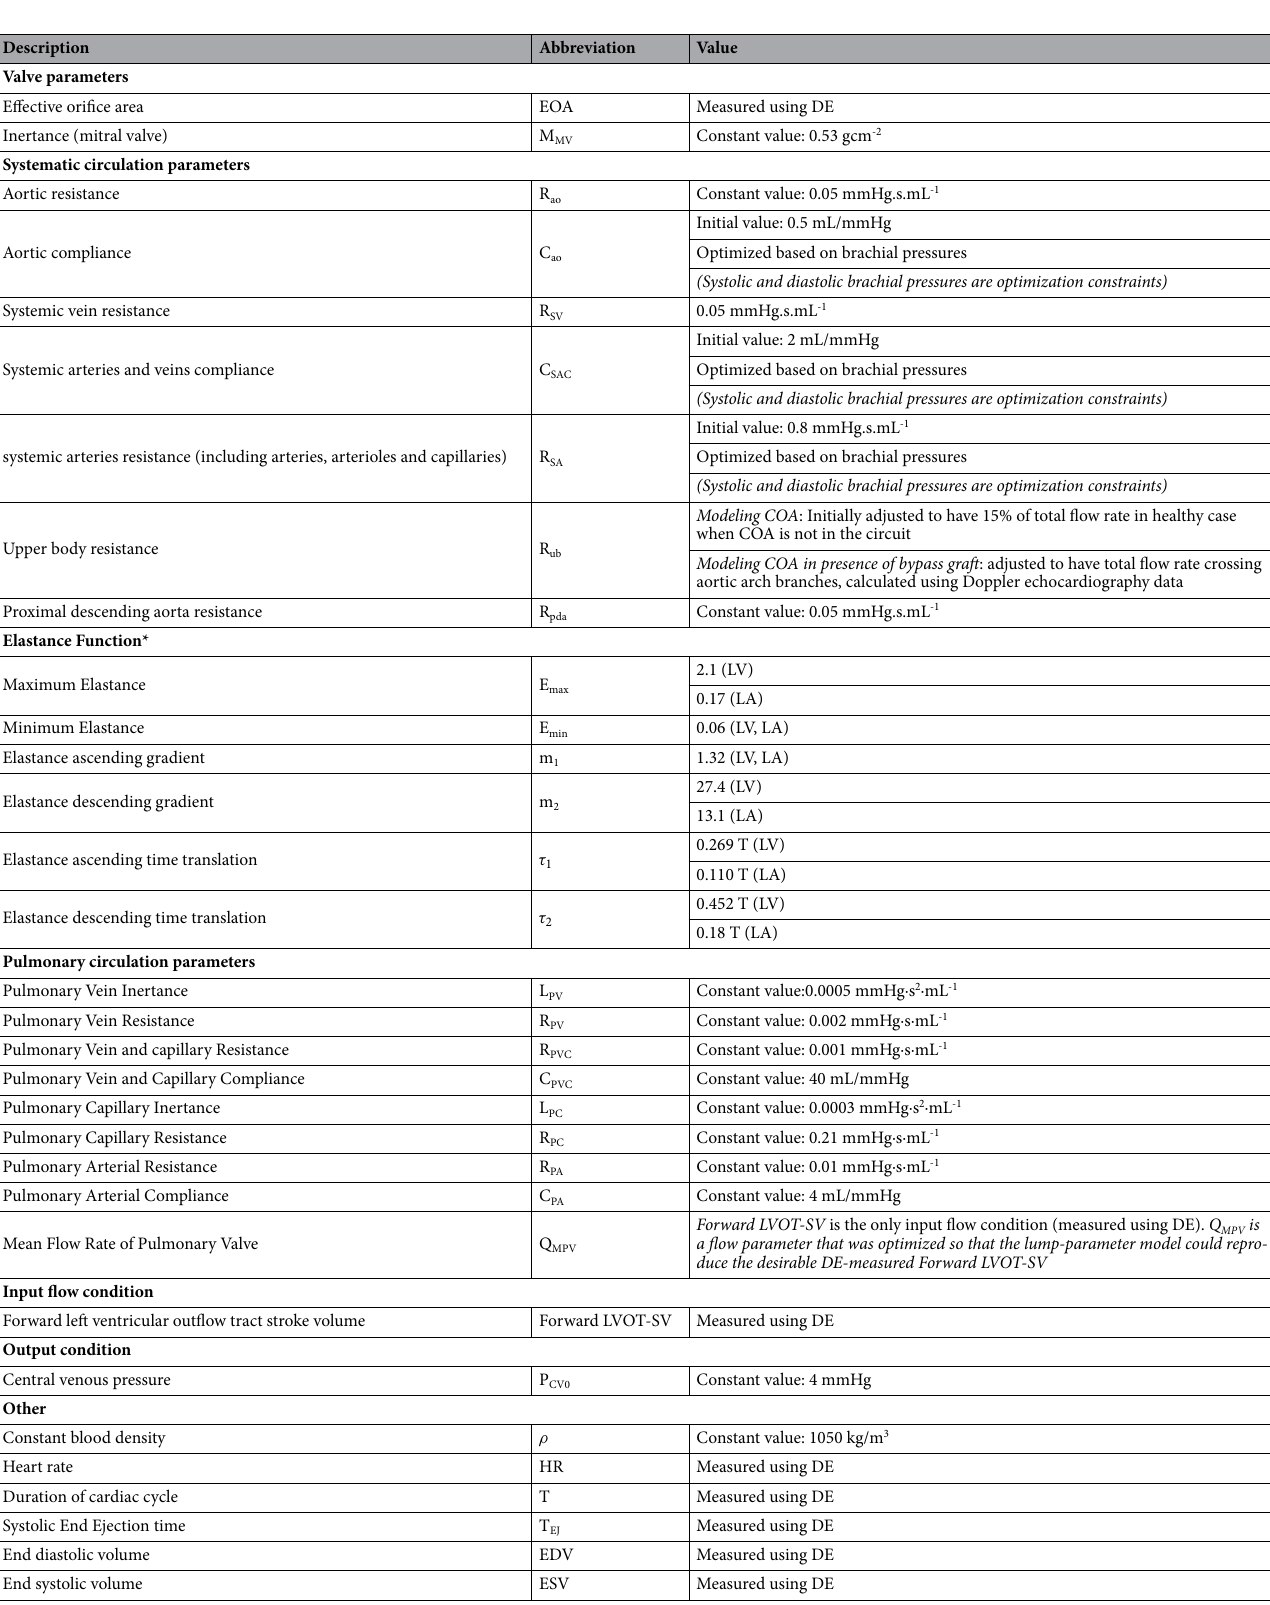
Table 1. Summarized parameters used in the lumped parameter modeling to simulate all